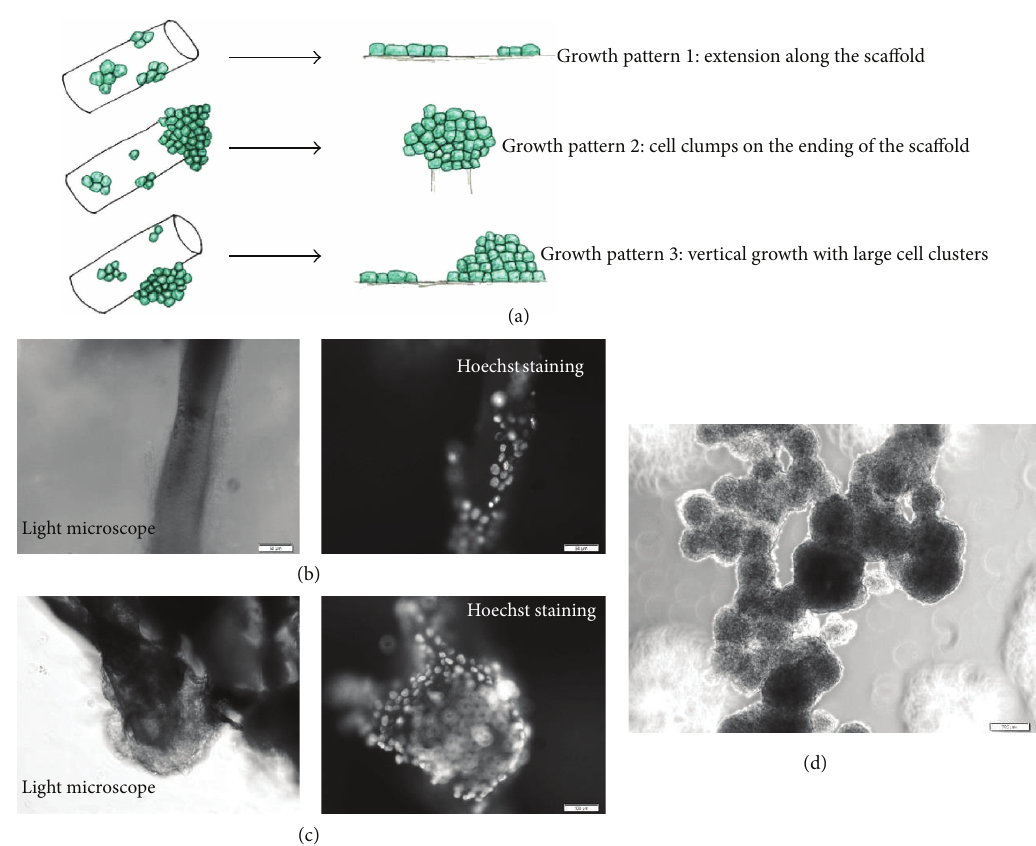
Figure 5: (a) Illustration of three types of growth pattern on the scaffolds. (b) to (c) showing the identical microscopic view under light (left panel) and fluorescent filters (right panel); (b) an example of form A growth; (c) an example of form (b) and (c) vertical growth; (d) large cell clumps detached from scaffold grow as tumour spheroid. Scale bars are (b) and (c) = 50 𝜇 m, (d) = 200 𝜇